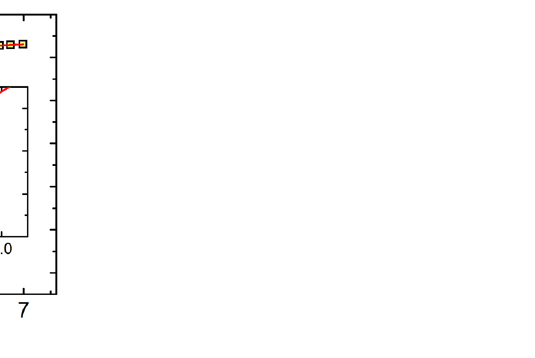
Figure 5. M–H curve at T C = 103 K and inset shows log-log plot of the curve. Solid line represents the fit to the Eq. (10) and yields δ = 14.668 ± 0.002 mentioned in graph is obtained from the fit to the Eq. (10). (The figure has been drawn using OriginPro 2015